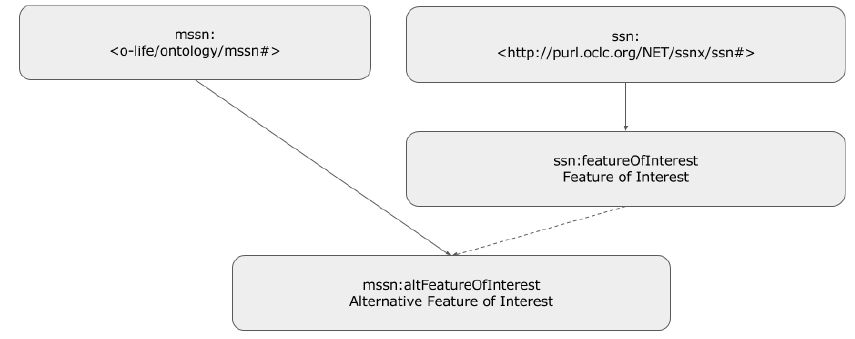
Figure 9. Alternative feature of interest.